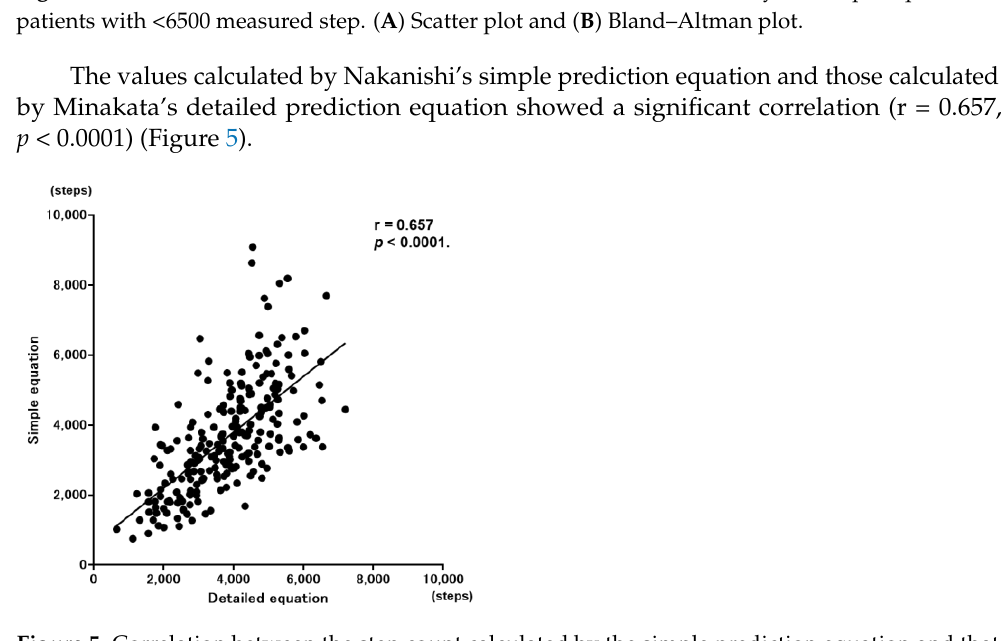
Figure 5. Correlation between the step count calculated by the simple prediction equation and that calculated by the detailed prediction equation.